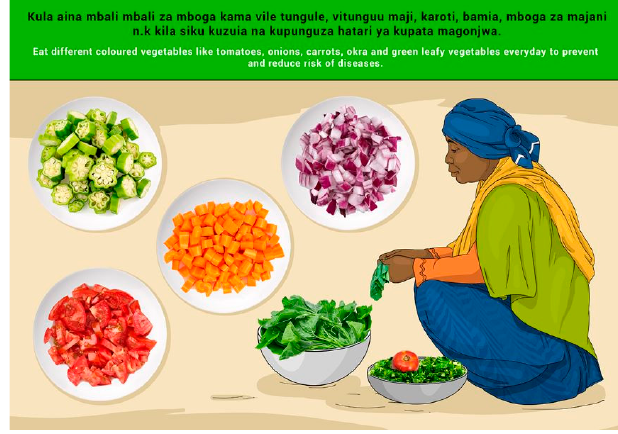
Figure 6. Revised message and image 4 for Mainland and Zanzibar: Eat different coloured vegetables such as tomatoes, onions, carrots, okra and green leafy vegetables every day to prevent and reduce risk of diseases.